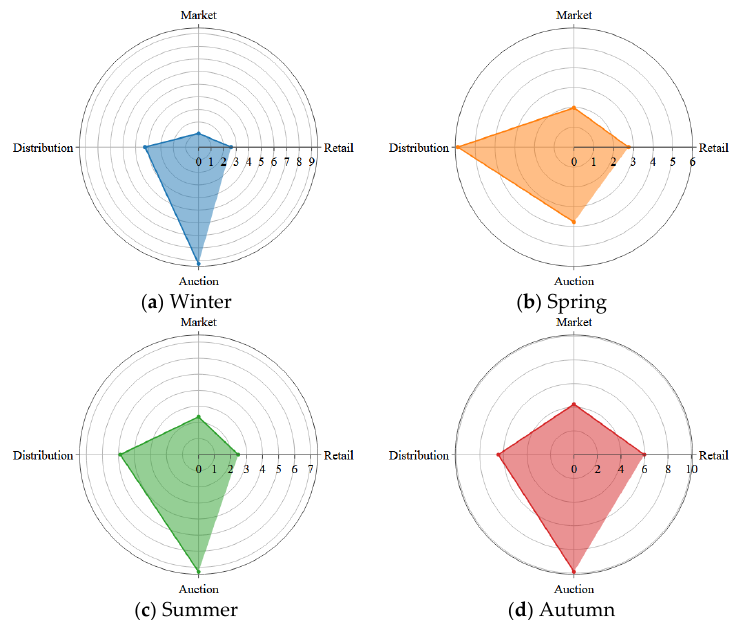
Figure 9. Comparison of different types of prices (as measured by MAPE).